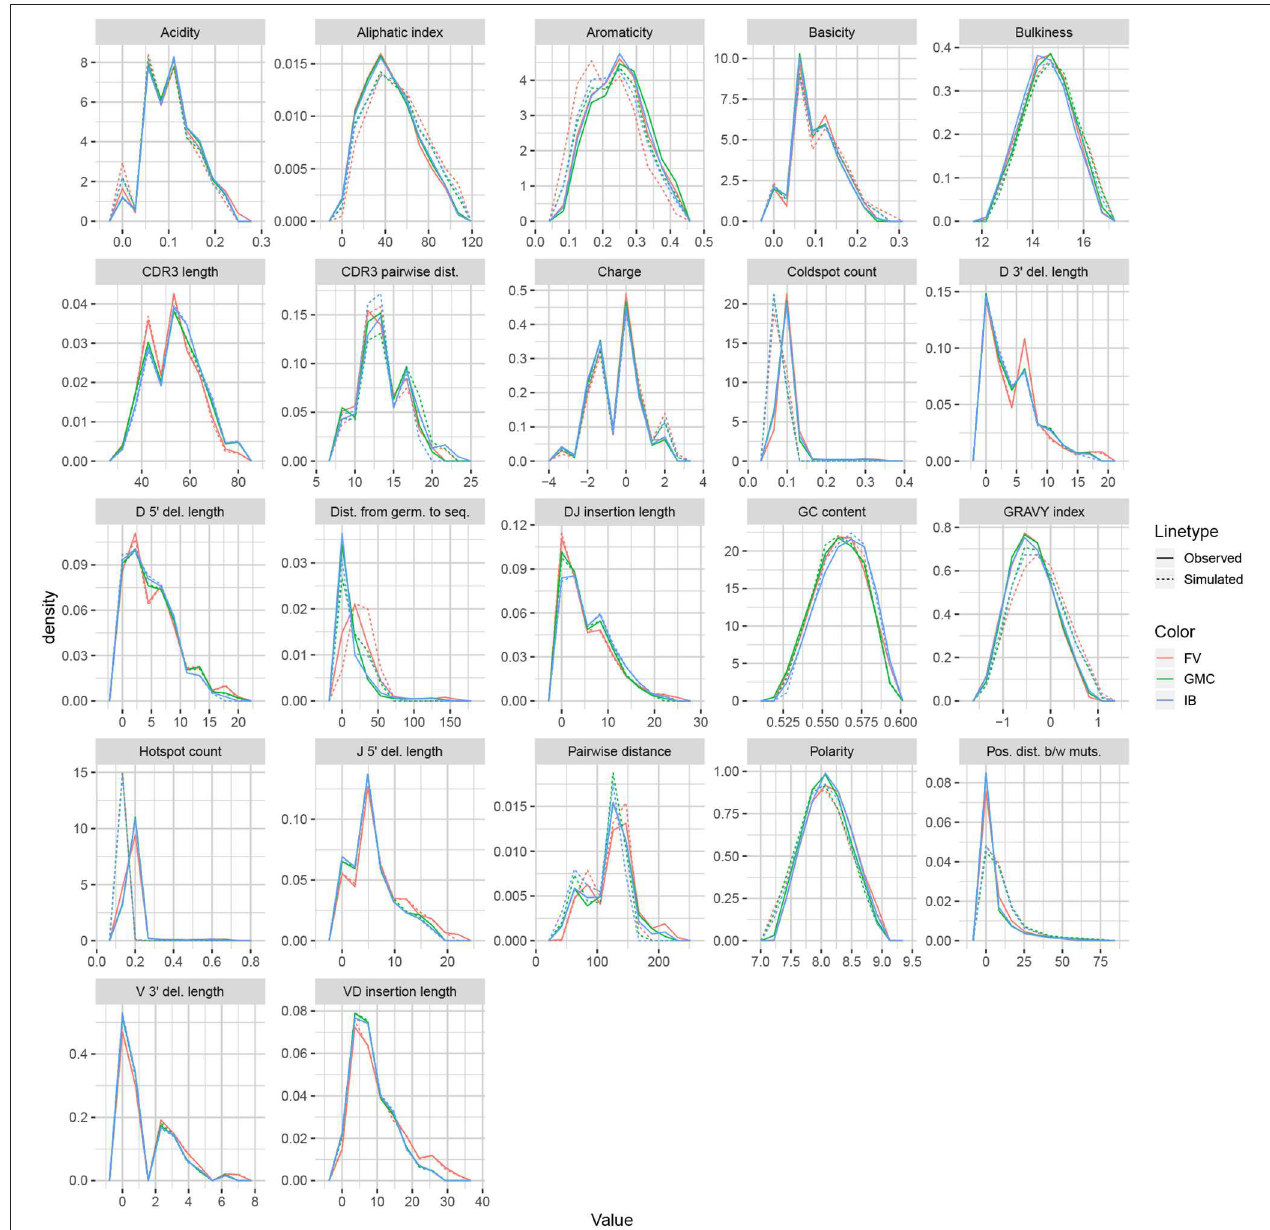
FIGURE 8 | Frequency polygon plots of each univariate summary distribution for the partis